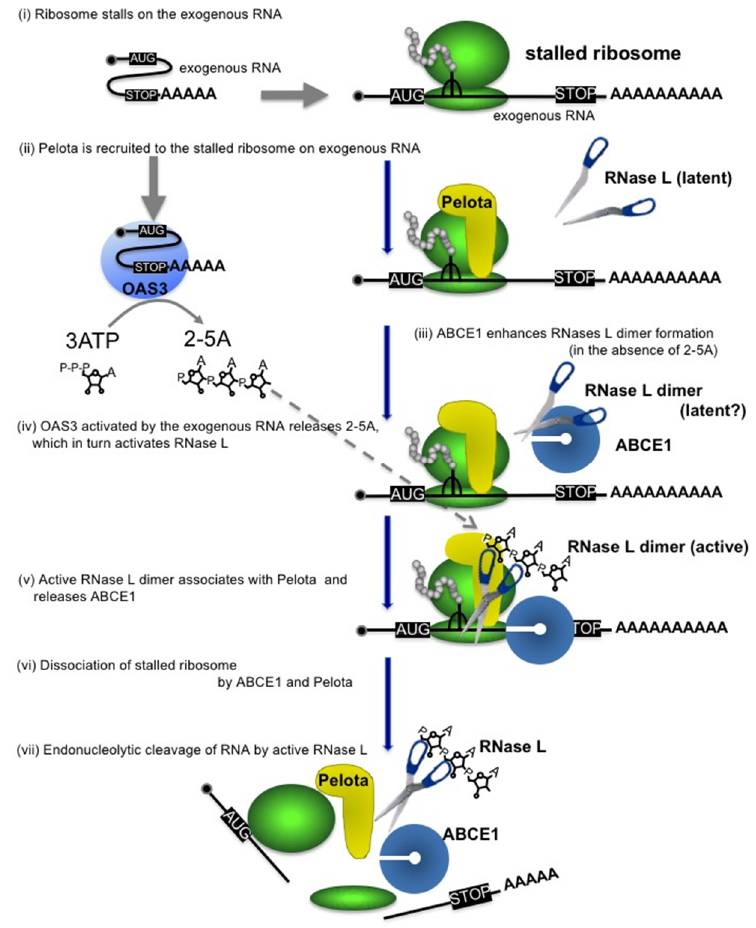
Figure 4. Proposed model for the ABCE1-mediated exogenous RNA decay. Pelota is recruited to the ribosome stalled on exogenous RNA. ABCE1 directly interacts with RNase L to enhance its dimerization, thereby accelerating formation of 2-5A-bound active dimer. ABCE1 released from RNase L interacts with Pelota and dissociates the ribosomes into large and small subunits. The activated RNase L degrades the exogenous RNA.